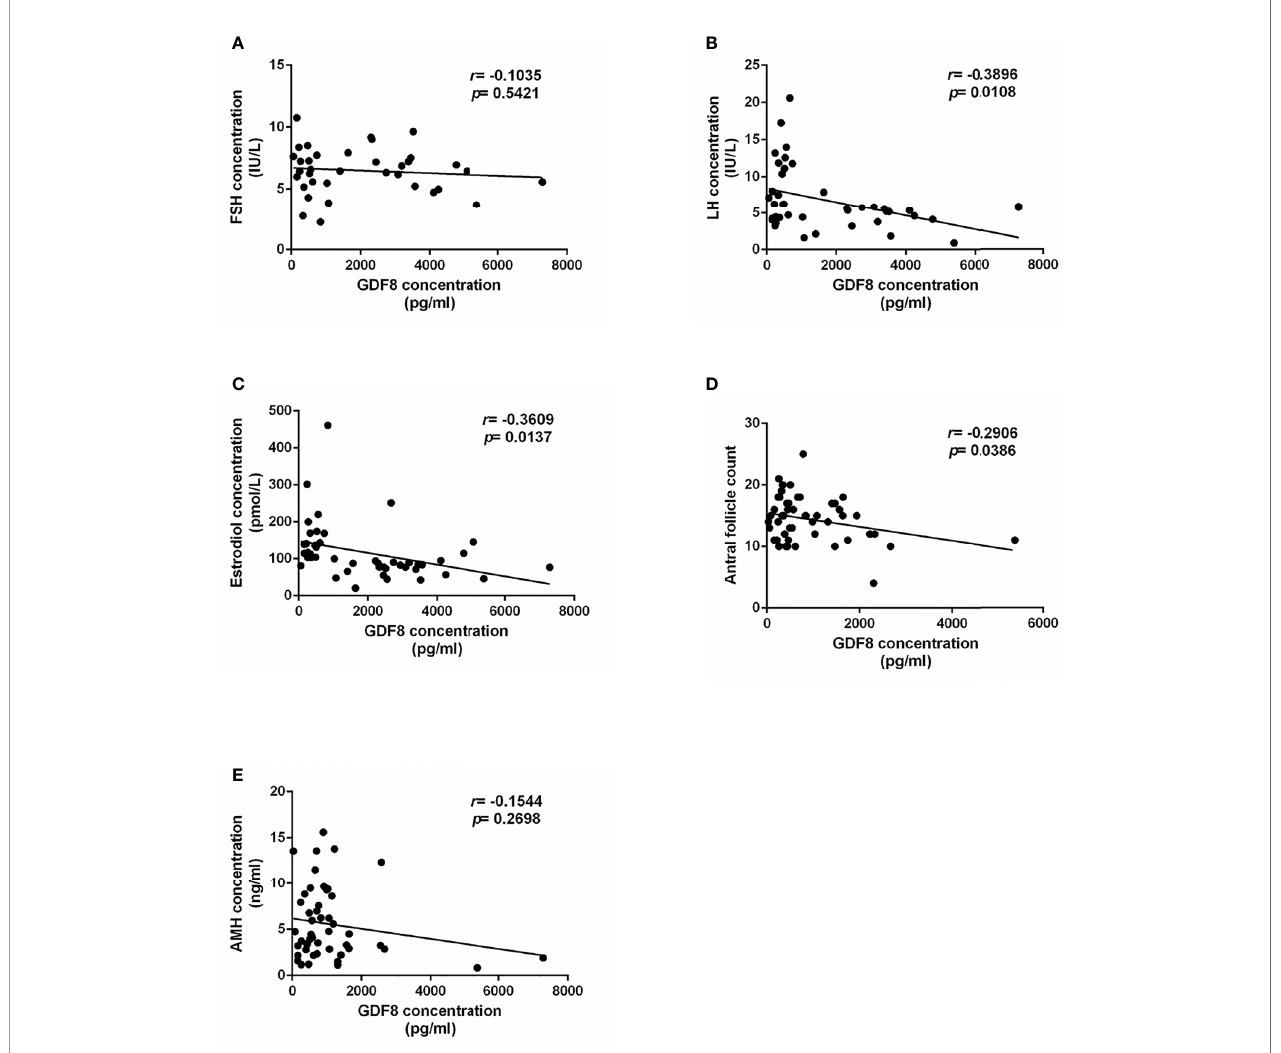
FIGURE 2 | The correlation analysis of GDF-8 and clinical ovarian response patients. (A – C) The correlation analysis of GDF-8 levels with hormone concentration, including FSH, LH, and estradiol. (D) The correlation analysis of GDF-8 levels with antral follicle count. (E) The correlation analysis of GDF-8 levels with AMH levels. The data were analyzed by the two-sample t test assuming unequal variances. P < 0.05 was considered statistically signi fi cant.